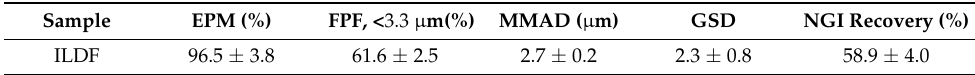
Table 3. Summary of aerodynamic performance testing of the ILDF